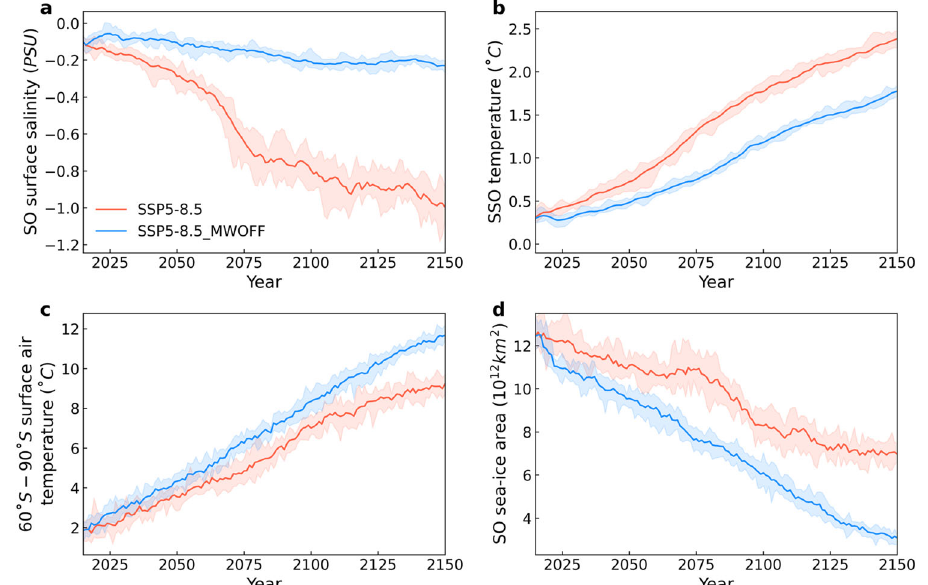
Fig. 5 | Climate-ice-sheet feedbacks in Southern Hemisphere. a – c Annual anomalies (relative to the 1850 – 1900 CE mean) of ( a ) the Southern Ocean (SO) surface salinity, ( b ) 400m subsurface Southern Ocean (SSO) temperature and ( c ) surface air temperature averaged between 60°S and 90°S. d is the SO sea-ice area